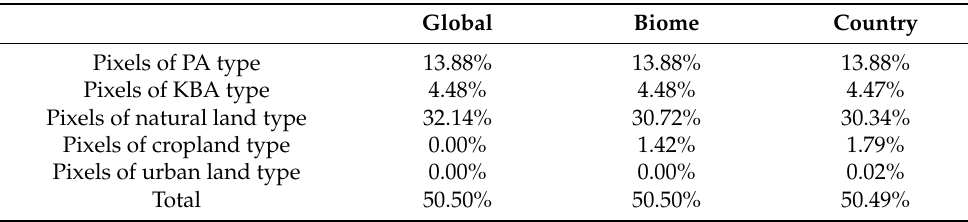
Table 3. 2050 nature-only: percentage of conserved area to global terrestrial area. Global Biome Country